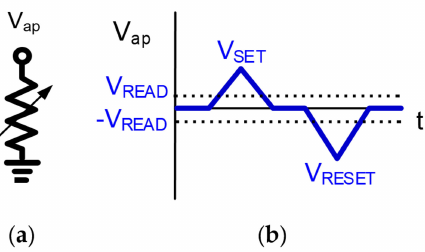
Figure 2. ( a ) Schematic device measurement configuration; and ( b ) Diagram of the applied voltage